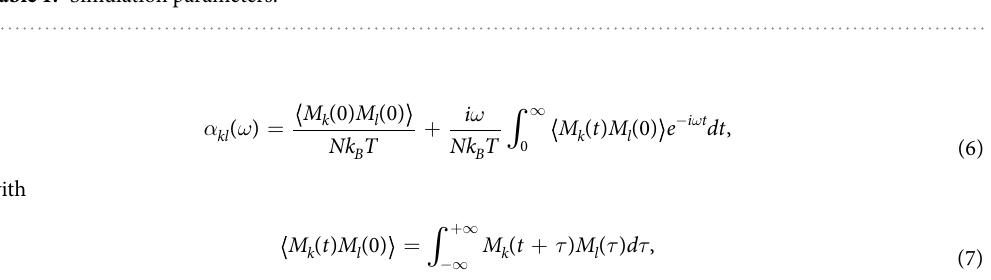
Table 1. Simulation